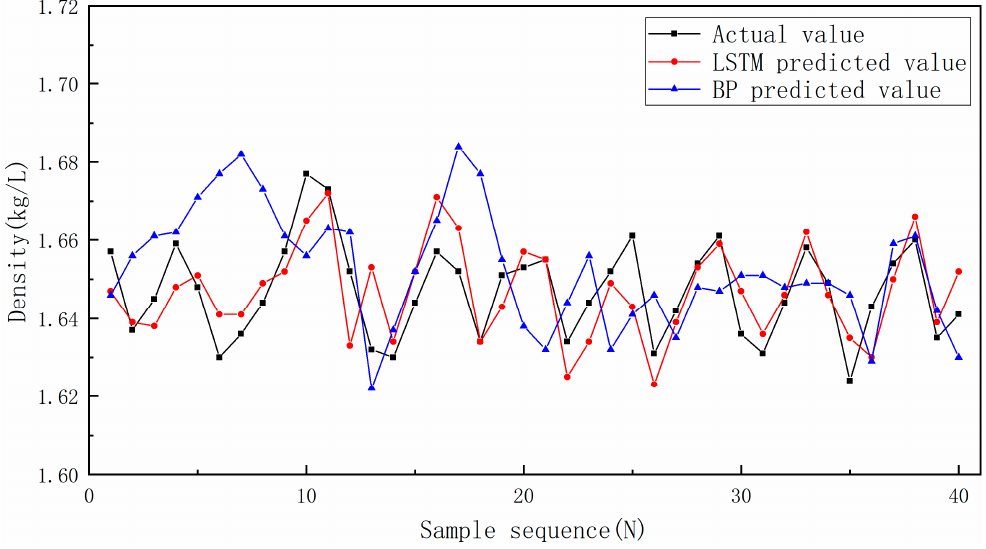
Figure 8. Performance of two models on the testing set.